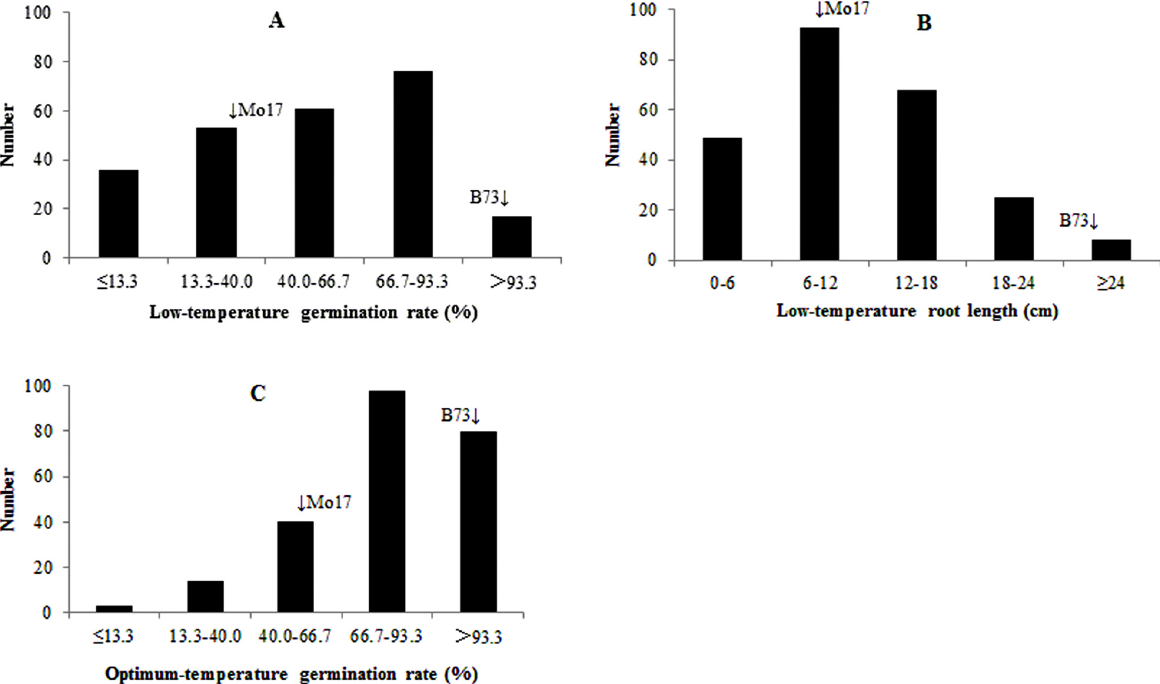
Fig 1. Histograms of frequency distributions of germination-related traits under low and optimum temperature in the IBM Syn4 population. A. Low- temperature germination rate, B. Low-temperature primary root length, C. Optimum-temperature germination rate.